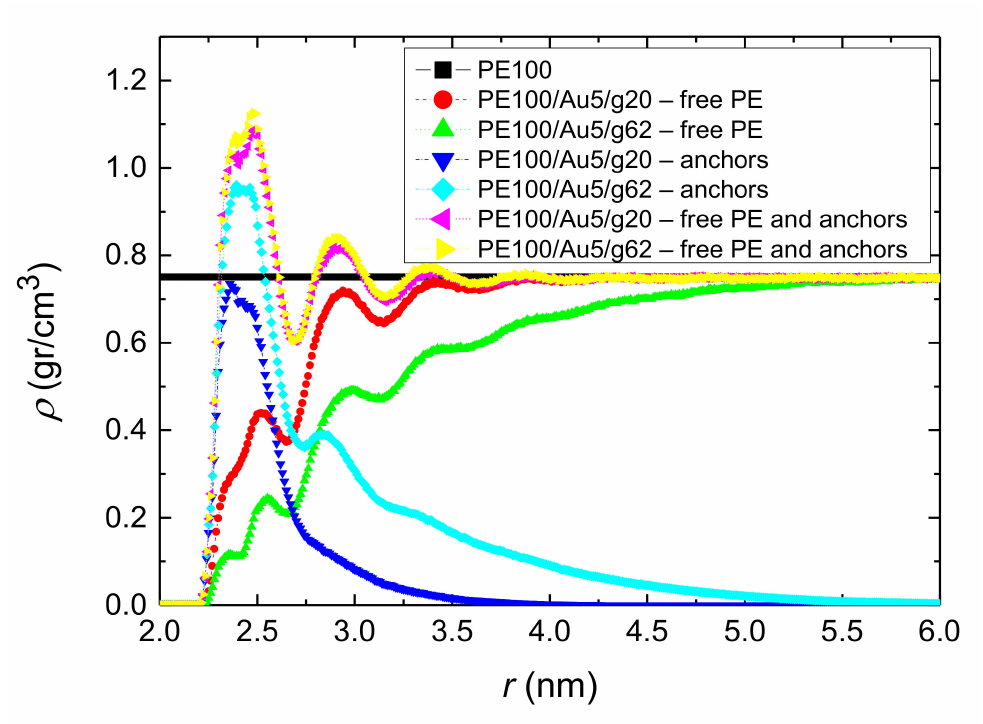
Figure 4. Mass monomer density profiles of polyethylene as a function of r (distance from the center of the gold NP). Au5/g20 and PE100/Au5/g62 systems. The density profile was decomposed to free polyethylene chains and grafted polyethylene